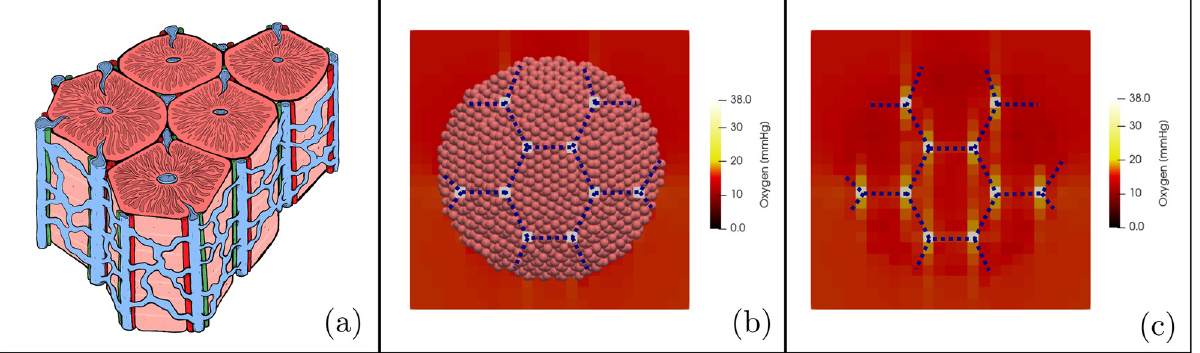
Fig 3. Liver blood vessels architecture. (a) Schematic representation of the hepatic lobules. They consist of plates of hepatocytes, and sinusoids radiating from a central vein interconnected with the interlobular portal triads: the hepatic artery (red), the portal vein (blue), and the common bile duct (green). (b) computational model of the liver parenchyma in which we can observe the blood vessel architecture. (c) Heat map of the oxygen diffusion in the liver microenvironment. Blue dotted lines were drawn just as a guide to the